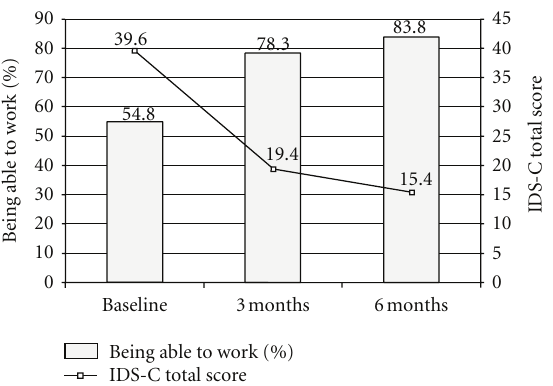
Figure 2: Percentage of patients being able to work and IDS-C total score at baseline, 3 months and 6 months.